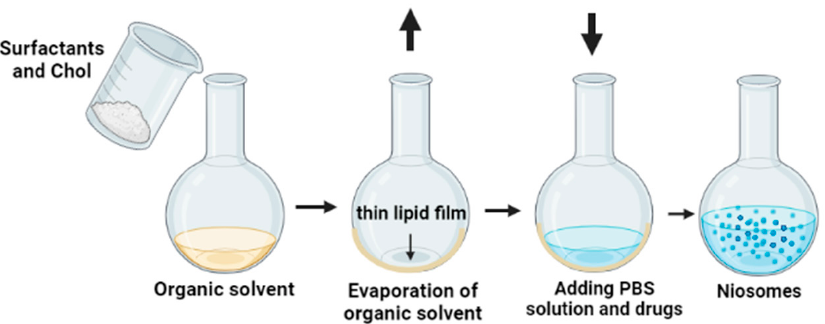
Figure 1. Schematic representation of the formulation of AA and CAFF niosomal nanoparticle.